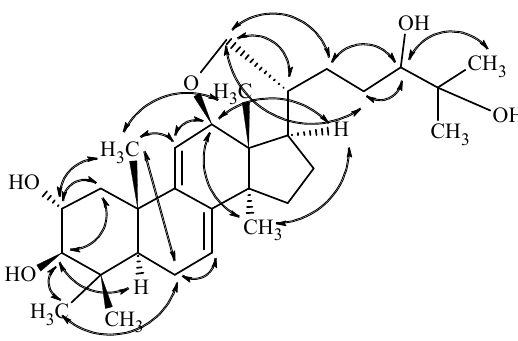
Figure 3. Key NOE correlations determined from the ROESY spectrum of compound 1.